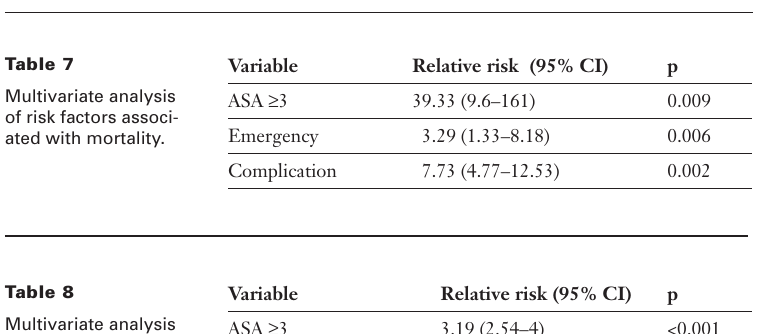
Multivariate analysis of risk factors associ- ated with